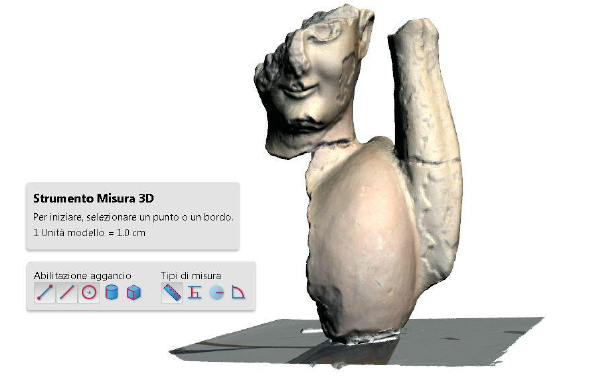
Figure 15. 3D model in PDF3D file format